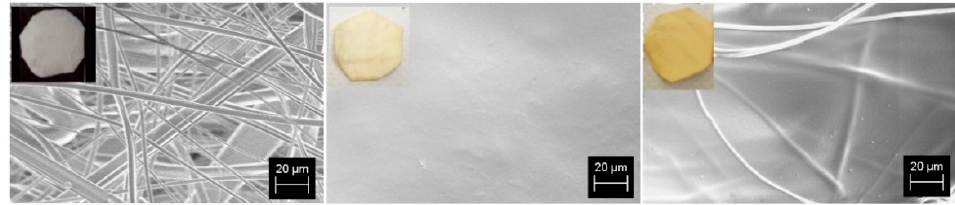
Figure 1. SEM images of PP ( left ), s-PBC@PP ( middle ) and s-PBC@PP after UV irradiation ( right ) samples.